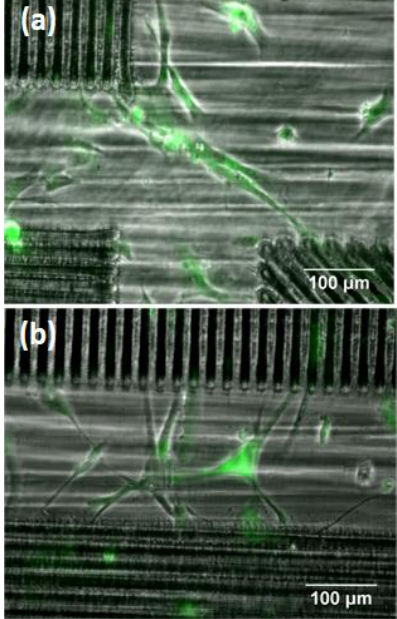
Figure 8. Human MSCs adhered on flat PLLA in between laser-patterned squares after 24 h in culture. Cell spreading from one groove endpoint to another of the second-nearest neighbor square ( a ), and from groove endpoints to groove edges of a first-nearest neighbor square ( b ). Images were treated by ImageJ to highlight cell morphology (green color).